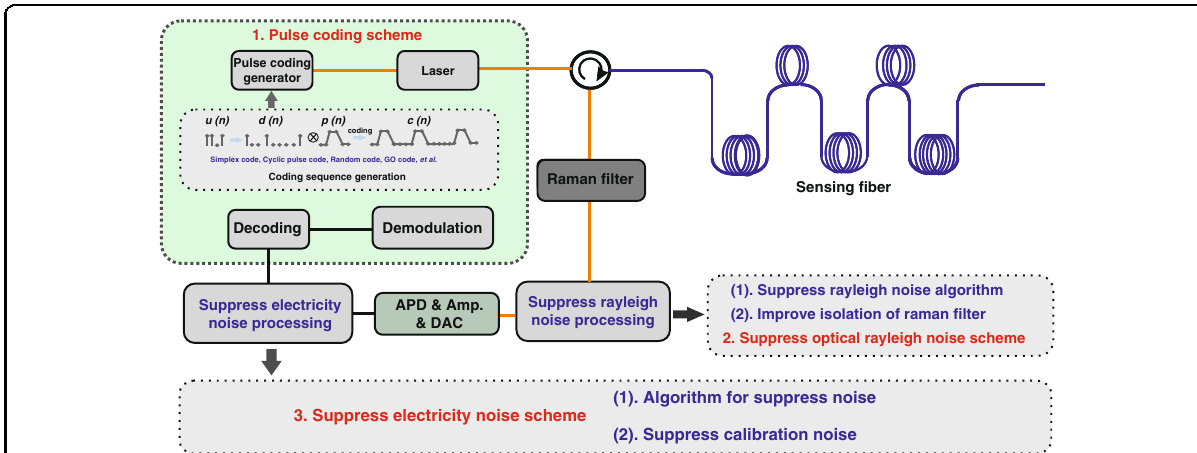
Fig. 5 Various denoising schemes in improving temperature measurement accuracy performance. Among them, the pulse coding scheme can increase the luminous fl ux incident on the sensing fi ber under the premise of suppressing the nonlinear effect of the fi ber, thereby improving the SNR. Algorithm denoising, noise suppression scheme in the calibration stage, and the Rayleigh optical noise suppression scheme improve the SNR by suppressing the electrical noise and optical noise, respectively. Table 3 Typical pulse coding schemes and experimental results